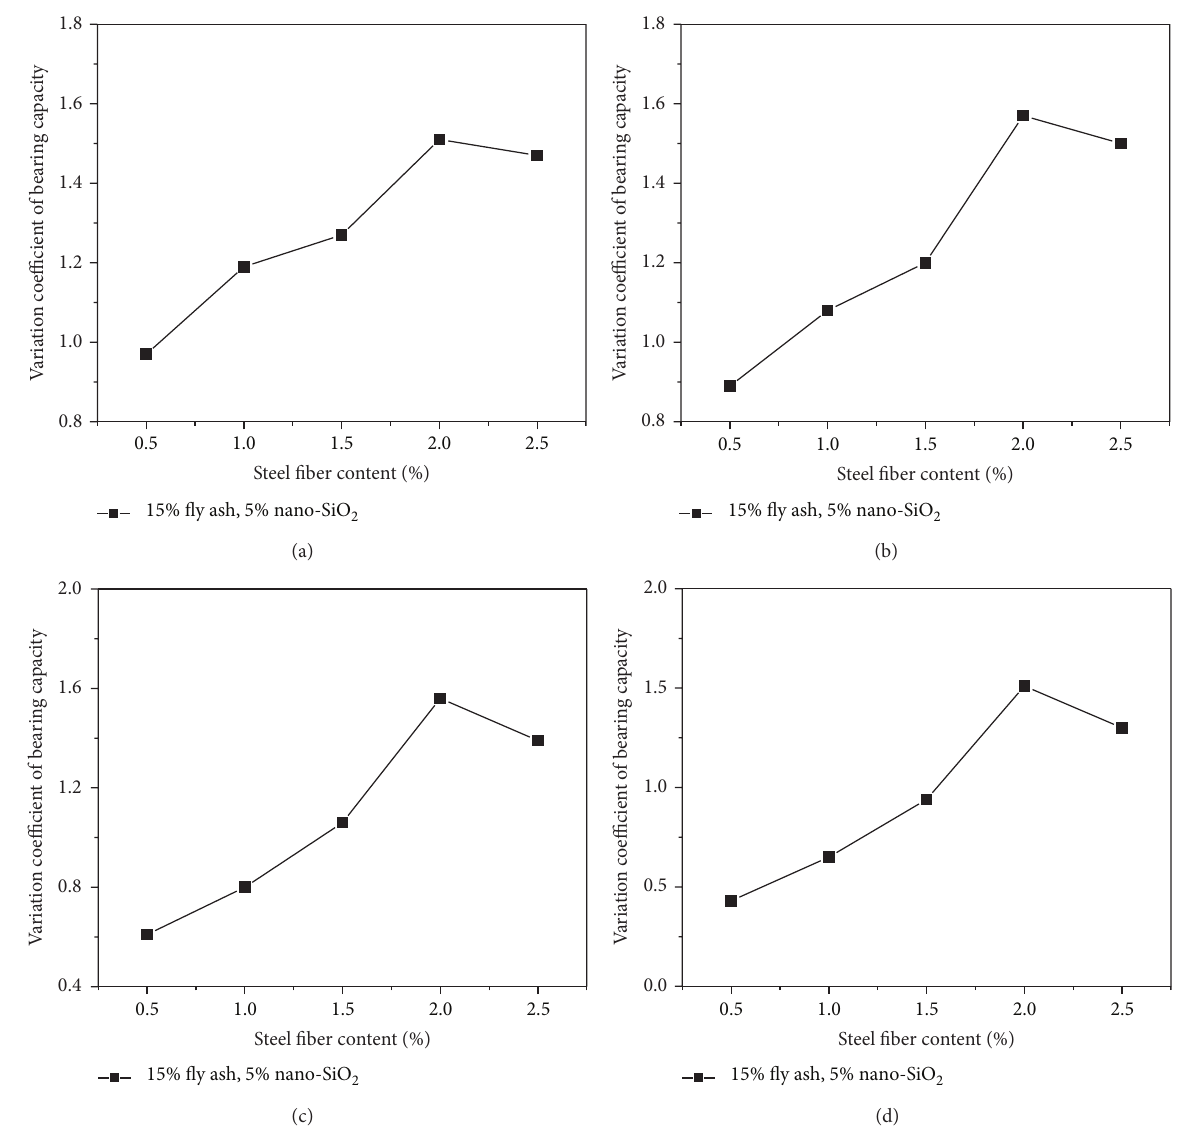
Figure 6: Effect of steel fiber content on variation coefficient of bearing